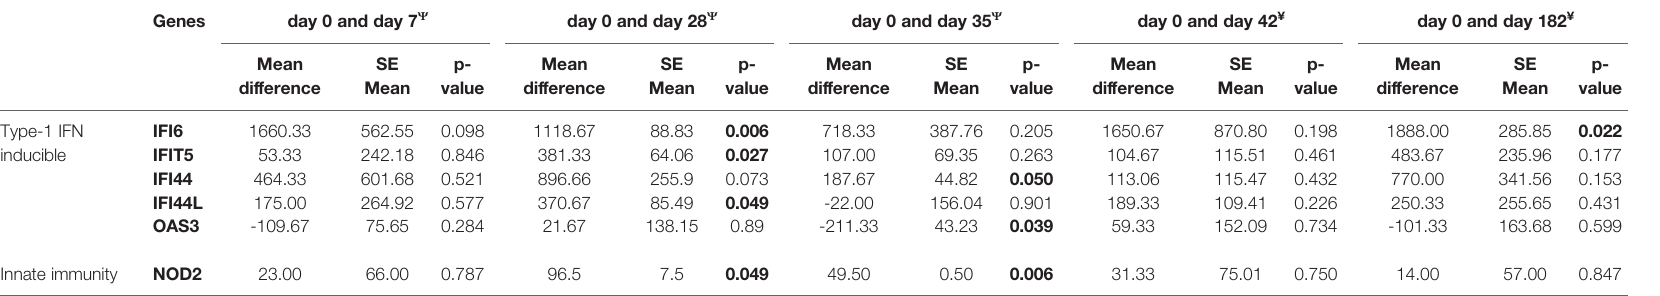
Innate immunity